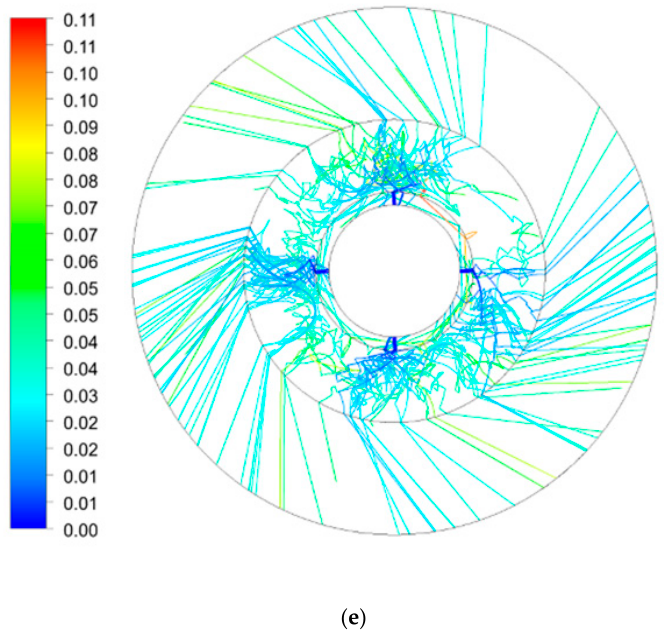
Figure 9. Residence time distribution in RPB under various initial droplet velocities and rotating speeds. ( a ) u 0 = 0.5 m / s, ω = 300 rpm; ( b ) u 0 = 0.5 m / s, ω = 600 rpm; ( c ) u 0 = 0.5 m / s, ω = 900 rpm; ( d ) u 0 = 1.5 m / s, ω = 600 rpm; ( e ) u 0 = 2.5 m / s, ω = 600 rpm.